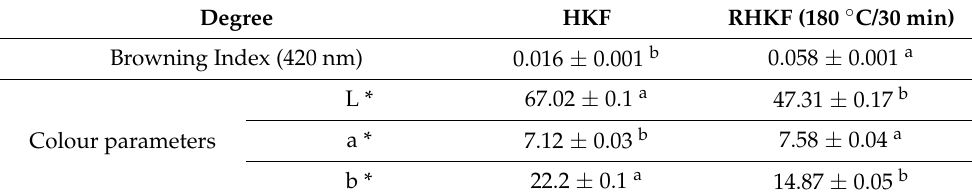
Table 2. Browning index and colour characteristics in raw and roasted Hass avocado kernels.